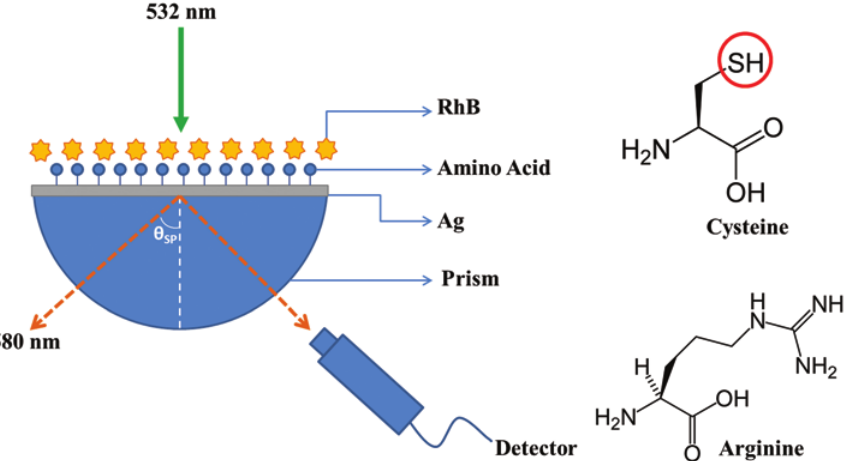
Figure 1: A schematic depicting the reverse Kretschmann (RK) configuration to monitor the SPCE signal arising at the surface plasmon angle ( θ ) on exposure to the different amino acids, namely, non-thiolated Arg and thiolated (-SH group) Cys that forms high-affinity Ag-S SP covalent bonds, facilitating its sensitive